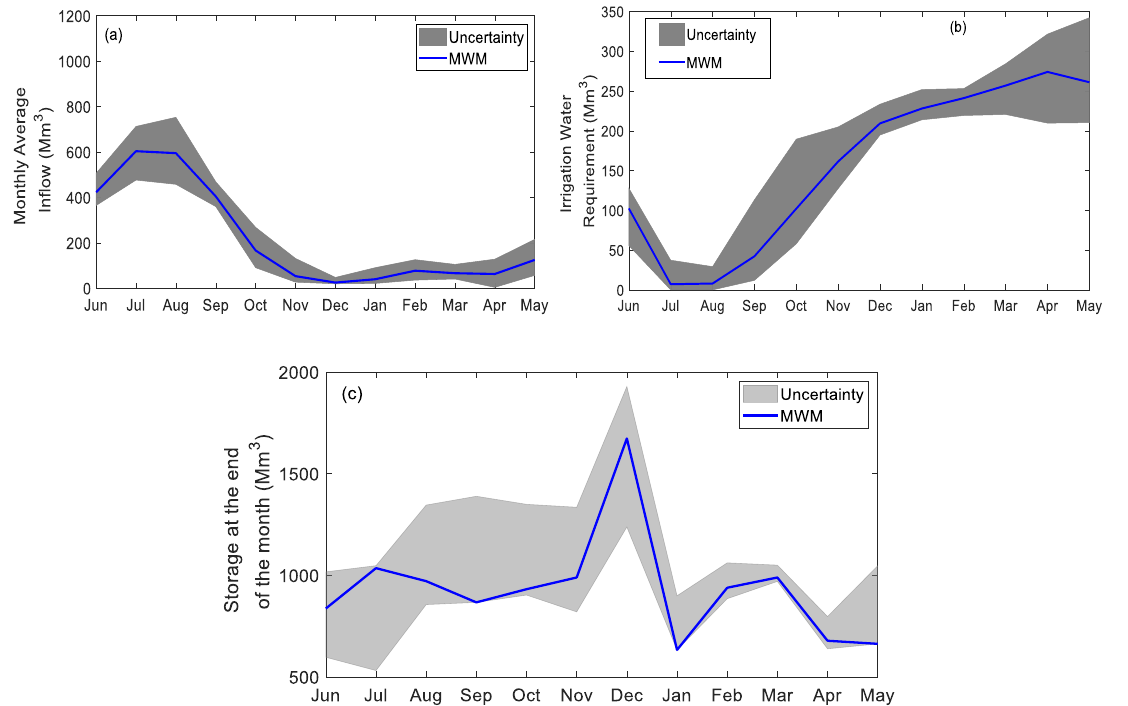
Figure 5. Regional water resource management model-associated uncertainties at each stage: ( a ) water availability model in terms of reservoir inflows; ( b ) demand estimation model such as irrigation water requirements; ( c ) operating policies in terms of storages. The results are for Bhadra river basin, India, showing maximum and minimum values along with multi weighted mean (MWM) hydro- climatology.